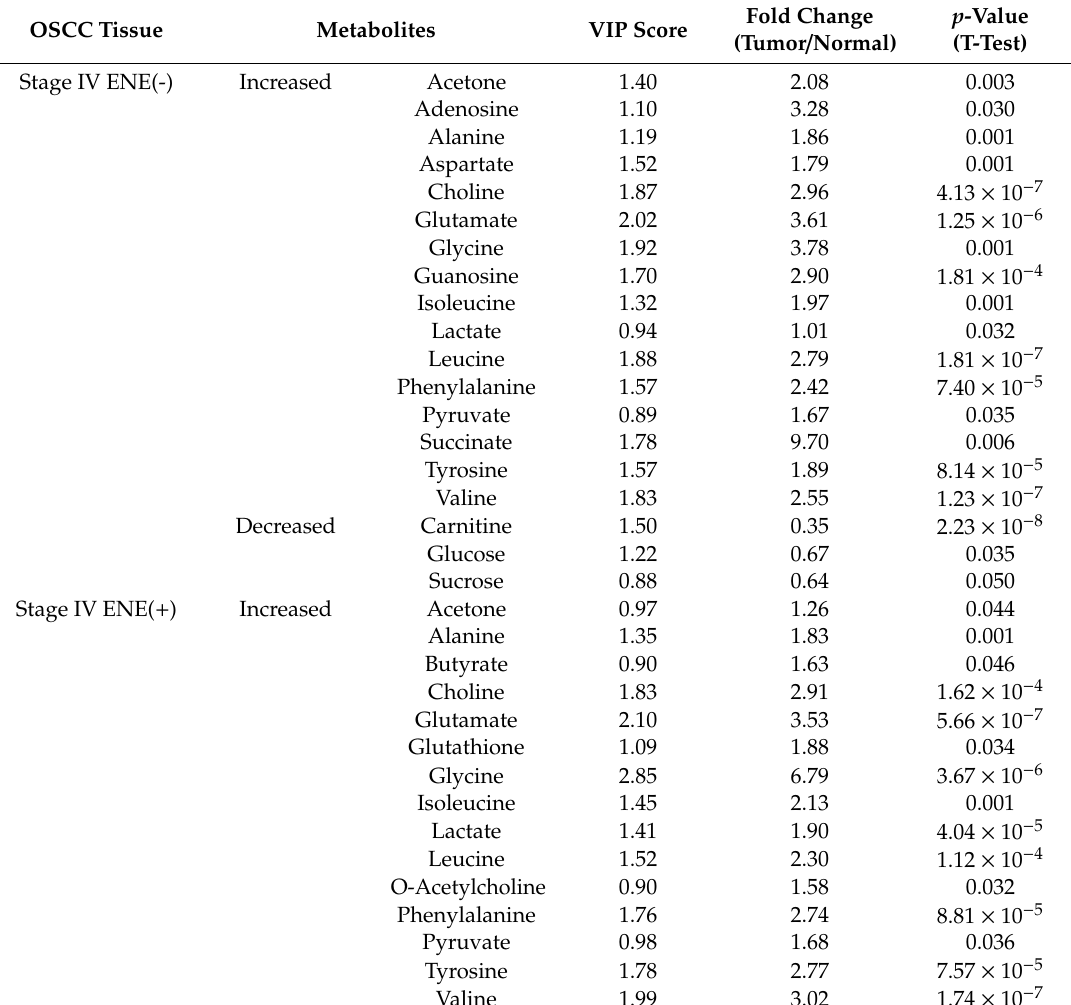
Table 3. Altered metabolites between tumor and adjacent normal tissue at stage IV oral squamous cell carcinoma